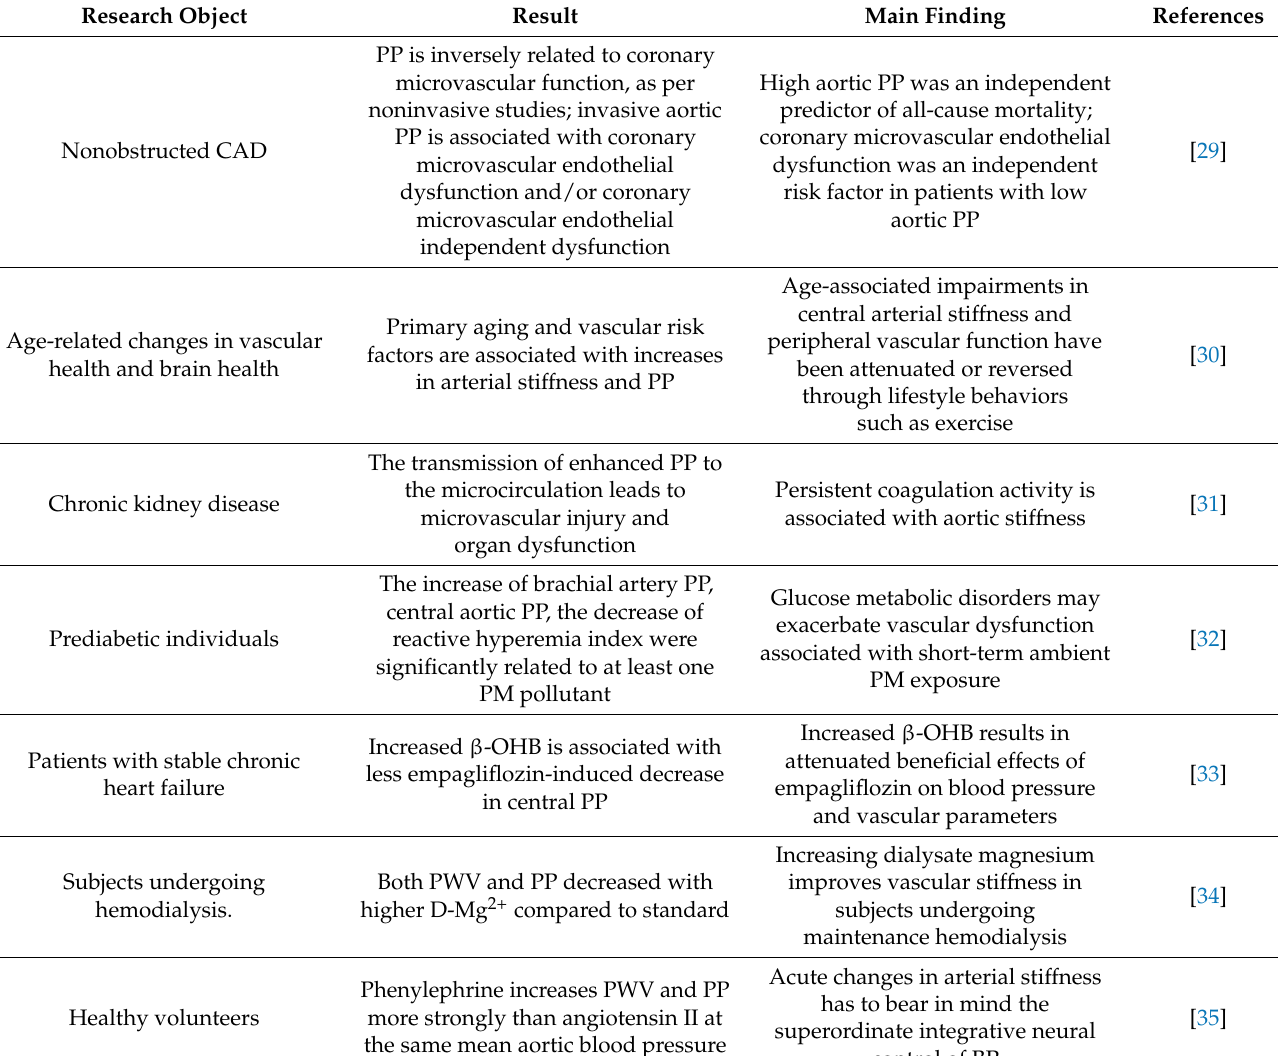
Table 1. Pulse pressure and endothelial function and